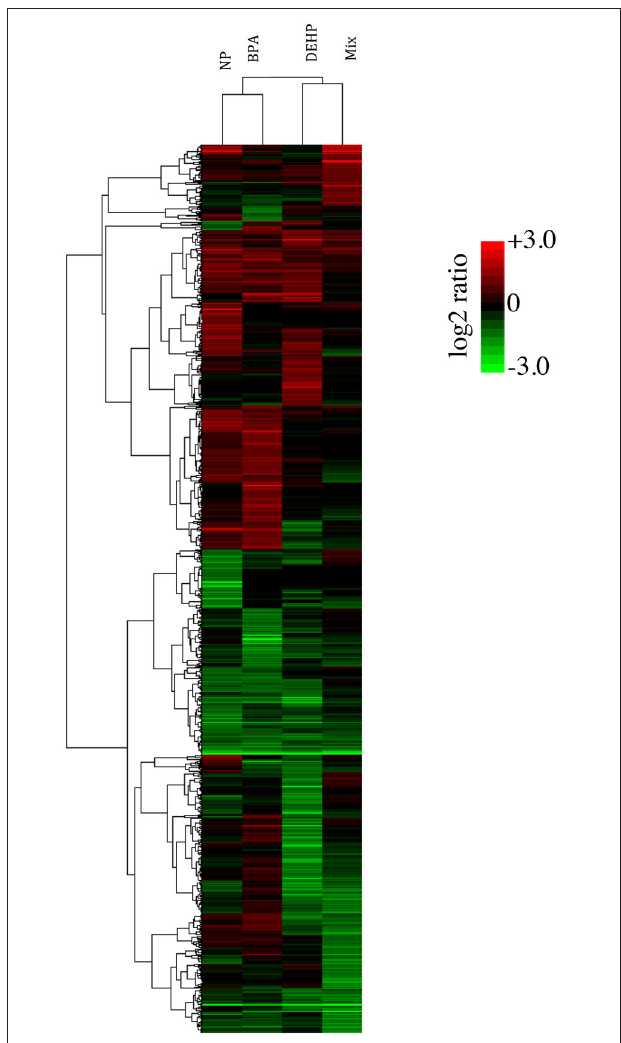
FIGURE 1 | Hierarchical cluster analysis (Pearson correlation) of differentially expressed-genes in the livers of male FHMs following 21 days exposure to 100 ug/L of NP, BPA, DEHP and their tertiary mixture ( p < 0.0001; fold change > 2). Green color represents down-regulated genes, red color represents up-regulated genes, and black color represents no change in response to EDC treatment relative to the untreated control. Color bar indicates log2 expression ratios of EDC treatment relative to untreated